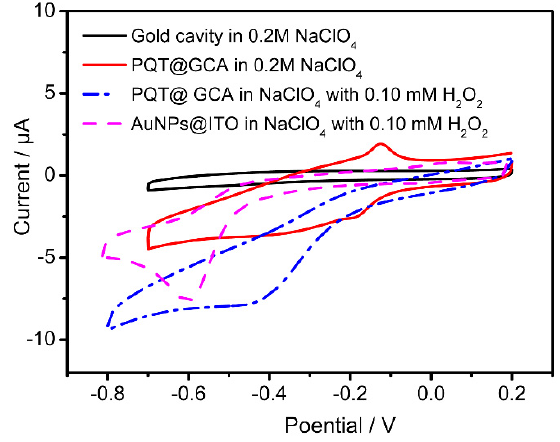
Figure 4. CV curves of the GCA electrode, PQT@GCA, and AuNPs@ITO electrode in 0.2 mol/L NaClO 4 with and without H 2 O 2 .